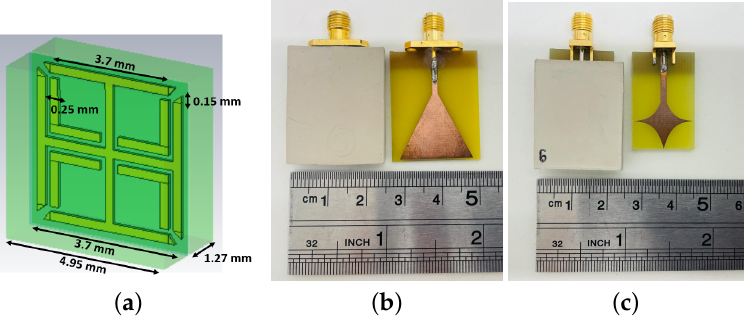
Figure 2. ( a ) Dimensions of the MTS unit cell ( b ) Photograph of the triangular patch antenna and its MTS-enhanced version ( c ) Photograph of the spear patch antenna and its MTS-enhanced version.